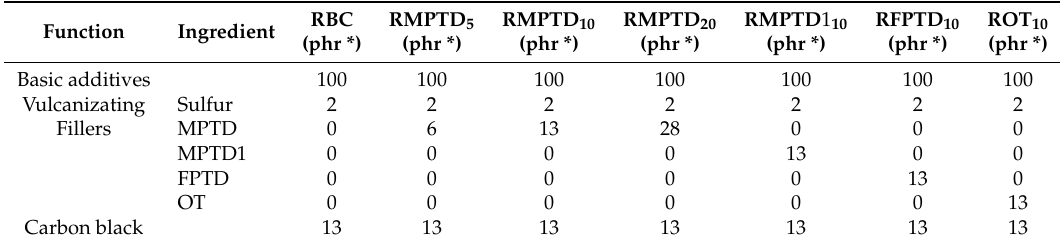
Table 2. Reinforced rubber compounds prepared from leather